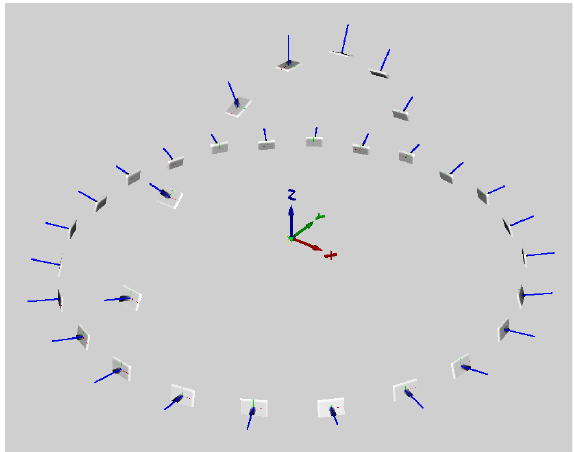
Figure 7: DI-One camera network and coordinate system.